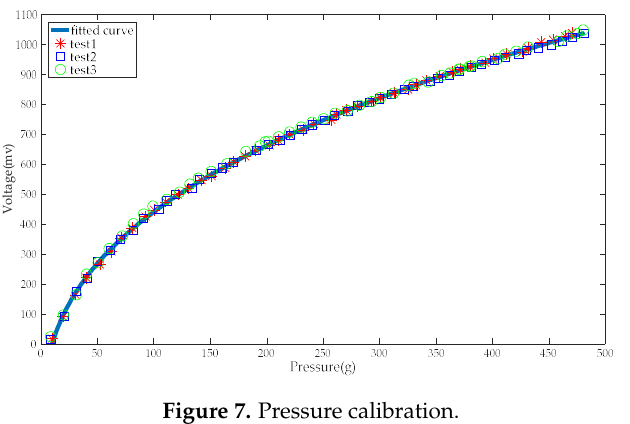
Figure 7. Pressure calibration. Figure 7. Pressure